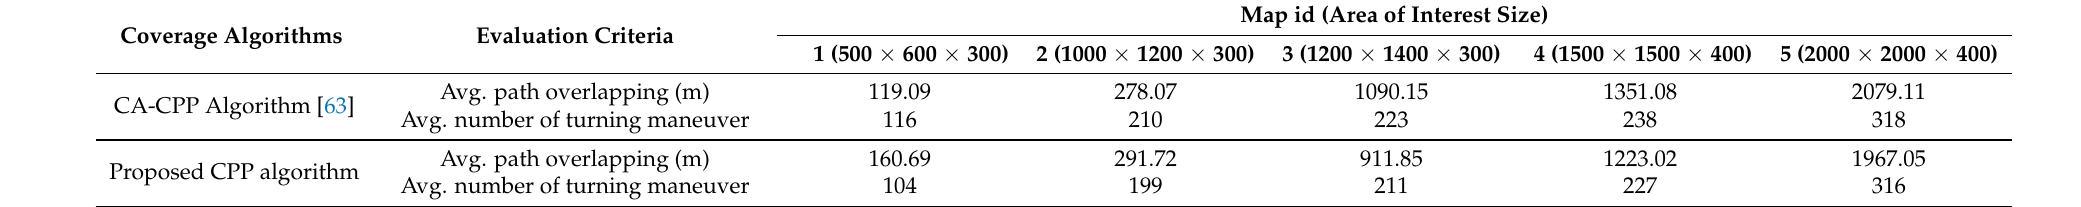
Table 4. Path overlapping comparison between three algorithms for the same area of